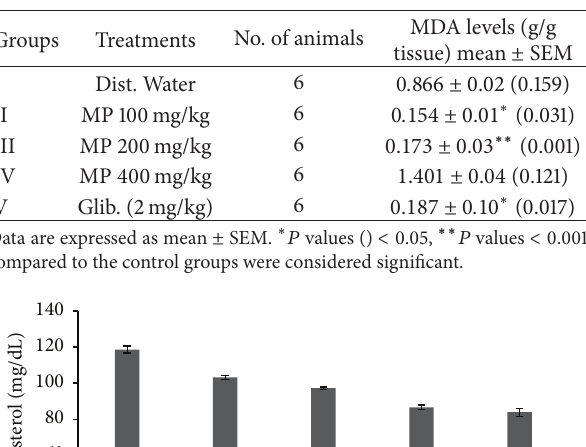
Table 2: Malondialdehyde (MDA) levels in the liver of diabetic rats treated with different doses of MP extract.